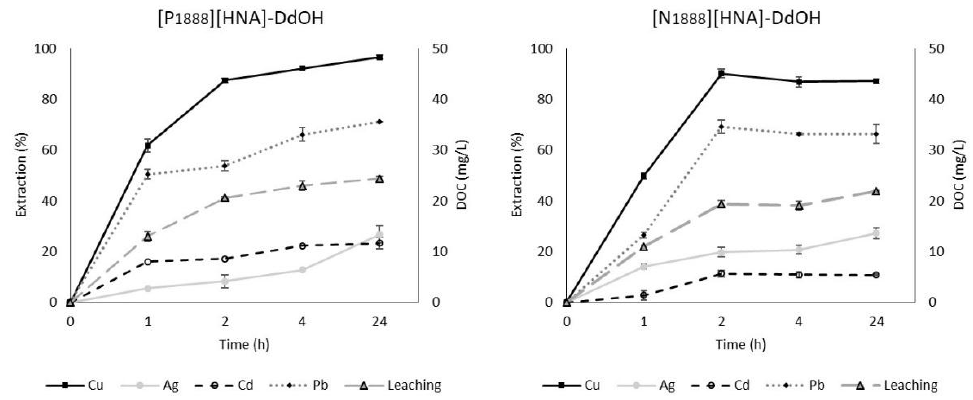
Figure 2. Time dependence of extraction and leaching using 50 wt% dodecan-1-ol (DdOH) mixtures of [P 1888 ][HNA] and [N 1888 ][HNA], respectively, pH = 8.0 (n = 3, error bars = ±